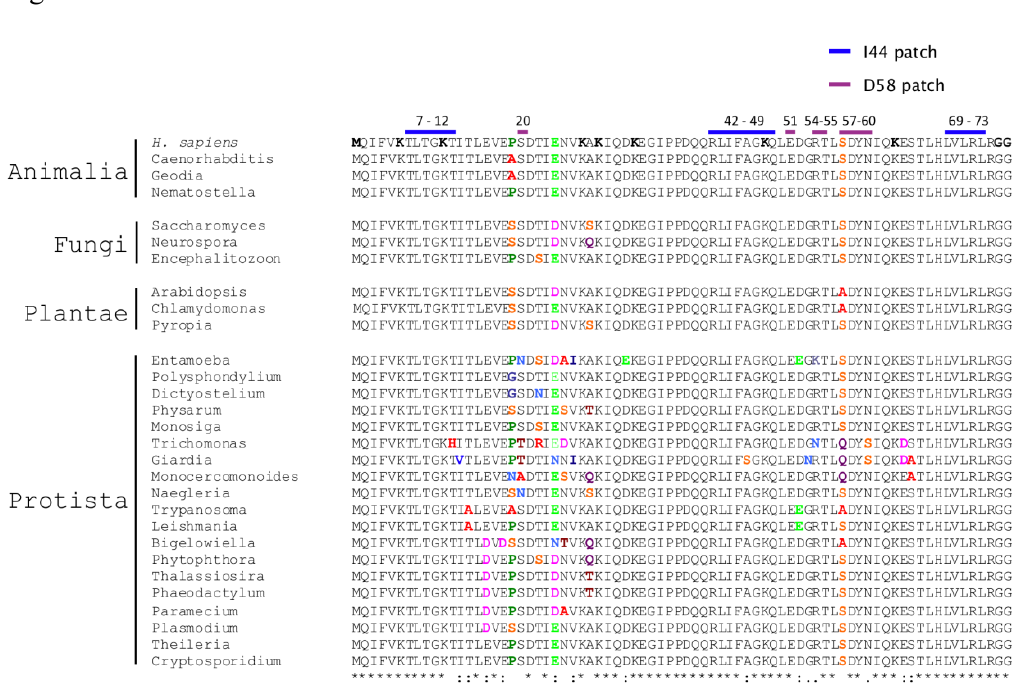
Figure 3. Strict conservation of functional traits of ubiquitin through evolution. Multiple alignment of eukaryotic ubiquitin protein sequences is shown. Proteins are grouped by eukaryotic kingdoms. On the top of the alignment, amino acids composing ubiquitin interactive surfaces (isoleucine 44 and aspartate 58 patches) are shown in blue and violet, respectively. The first aligned sequence, from H. sapiens, contains in bold the N-terminal methionine, the seven lysine residues and the glycine-glycine C-terminal motif involved in ubiquitin conjugation. At the bottom, Clustal similarity symbols are included. Within the alignment, positions that show no variation are shown in black. Amino acid variations are highlighted in